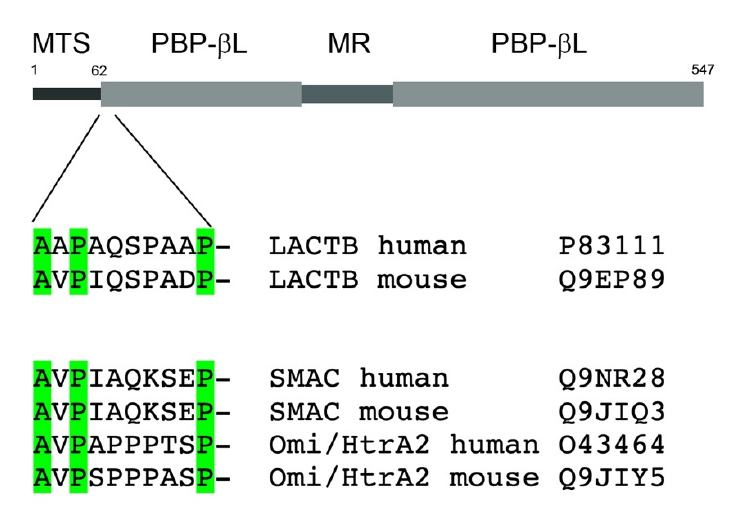
Figure 1. Structural elements of LACTB: MTS, mitochondrial targeting signal; PBP- β L, penicillin- binding and beta-lactamase homology domain; MR, middle region. The location of the potential IAP-protein binding N-terminal peptide motif in LACTB is indicated. Below a sequence comparison of IAP-protein binding motifs in the mitochondrial intermembrane space proteins SMAC and HtrA2.